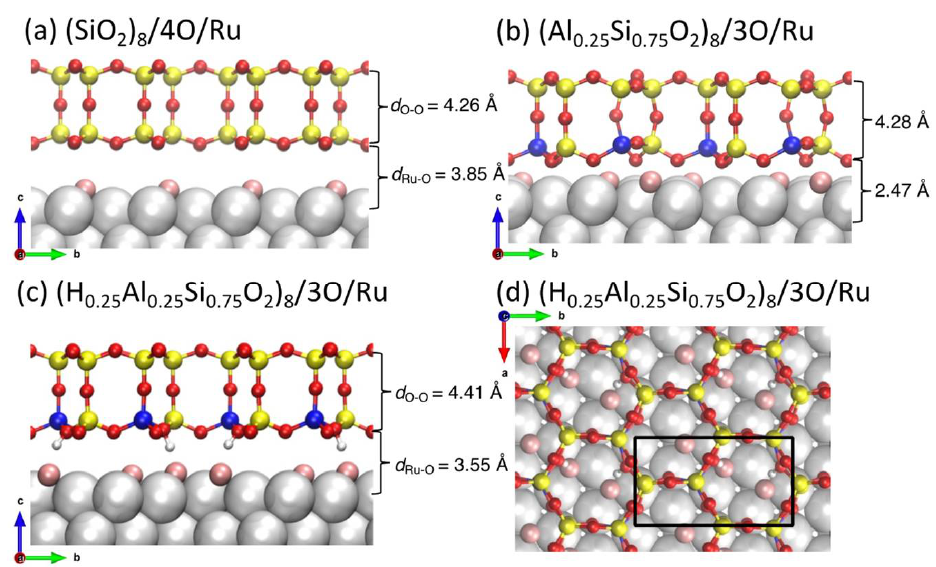
Figure 1. Atomic structures of ( a ) (SiO 2 ) 8 /4O/Ru and ( b ) (Al 0.25 Si 0.75 O 2 ) 8 /3O/Ru(0001). Side ( c ) and top ( d ) views of the bilayer aluminosilicate film growth on Ru(0001) with two H + bound to the bridging O in (Al–O − )–Si to compensate the framework charge [i.e., (H 0.25 Al 0.25 Si 0.75 O 2 ) 8 /3O/Ru(0001)]. The black rectangle on the top view ( d ) indicates the unit cell. Color code: Ru (silver), Si (yellow), Al (blue), H (white), O in aluminosilicate (red), and O chemisorbed on Ru (pink).